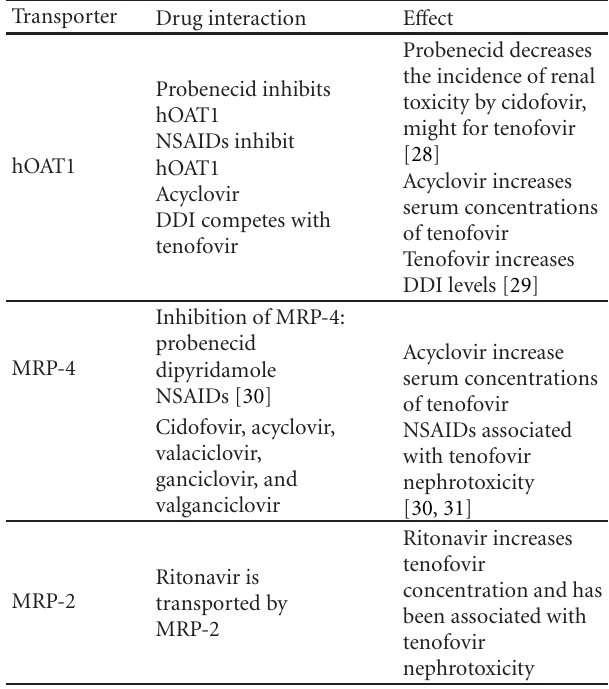
Table 1: Drugs interfering with proximal tubular tenofovir trans-